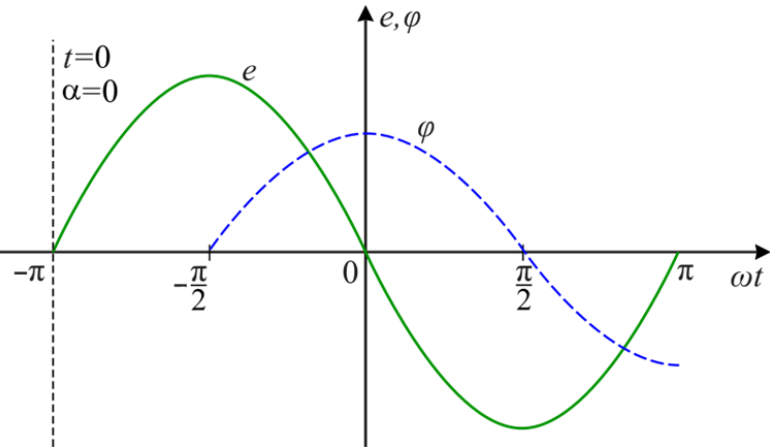
Figure 4. Course of the voltage supplying the transformer.